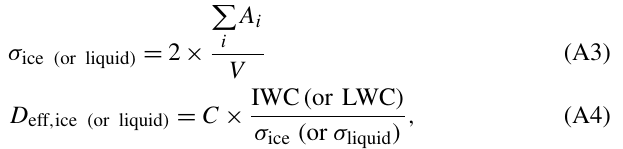
Figure B1. Comparison of extinction from PN and FSSP plus CPI measurements. Grey bars represent the 25% uncertainties on the PN extinction. The red dotted line is the linear fitting (slope of 0.98, R 2 = 0.87) and the blue dotted line is the 1 : 1